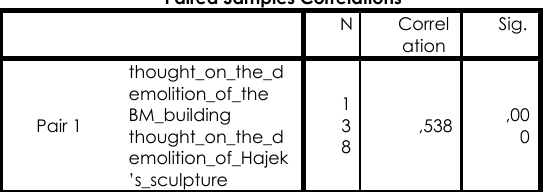
Table 4. Paired Samples Correlation among the participants thought on the demolitions of the Bank of Municipalities Building and Hajek’s sculpture. Paired Samples Correlations